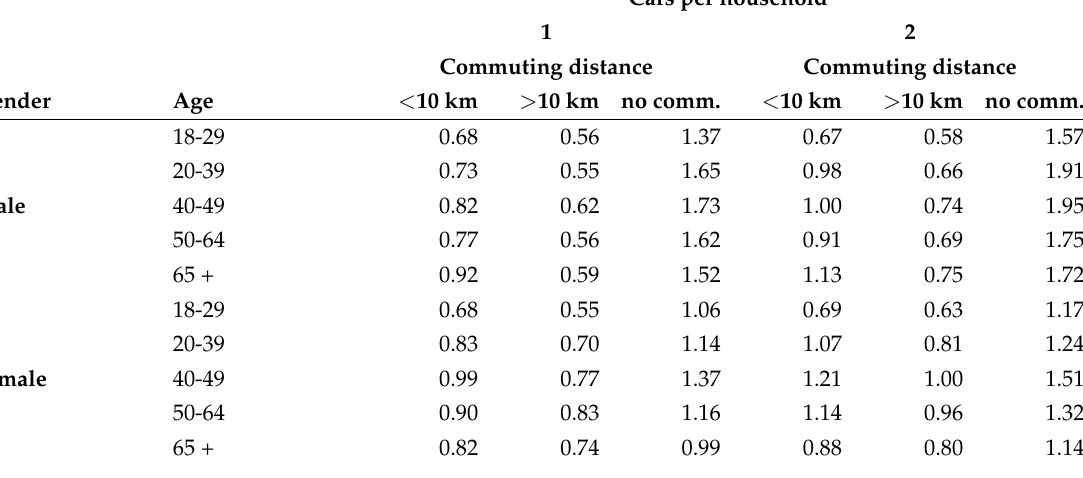
Table 5. EV penetration ratios for different socio-demographic groups of car owners ( < 1 means EV usage underrepresented; > 1 means EV ownership overrepresented), Scenario 3 Cars per